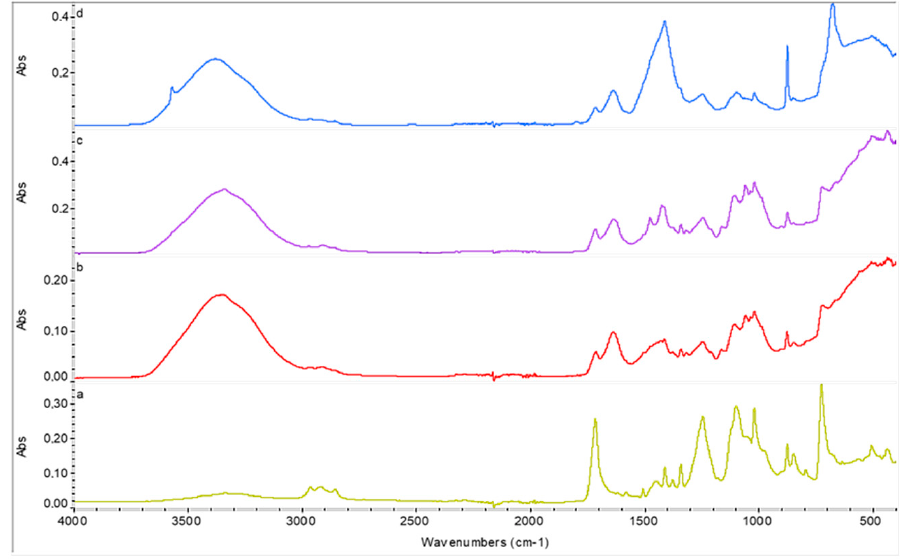
Figure 10. FTIR-ATR spectra analyses of fabrics coated with CaCl 2 : ( a ) untreated; ( b ) 10 wt % CaCl 2 ; ( c ) 25 wt % CaCl 2 ; ( d ) 50 wt % CaCl 2 .